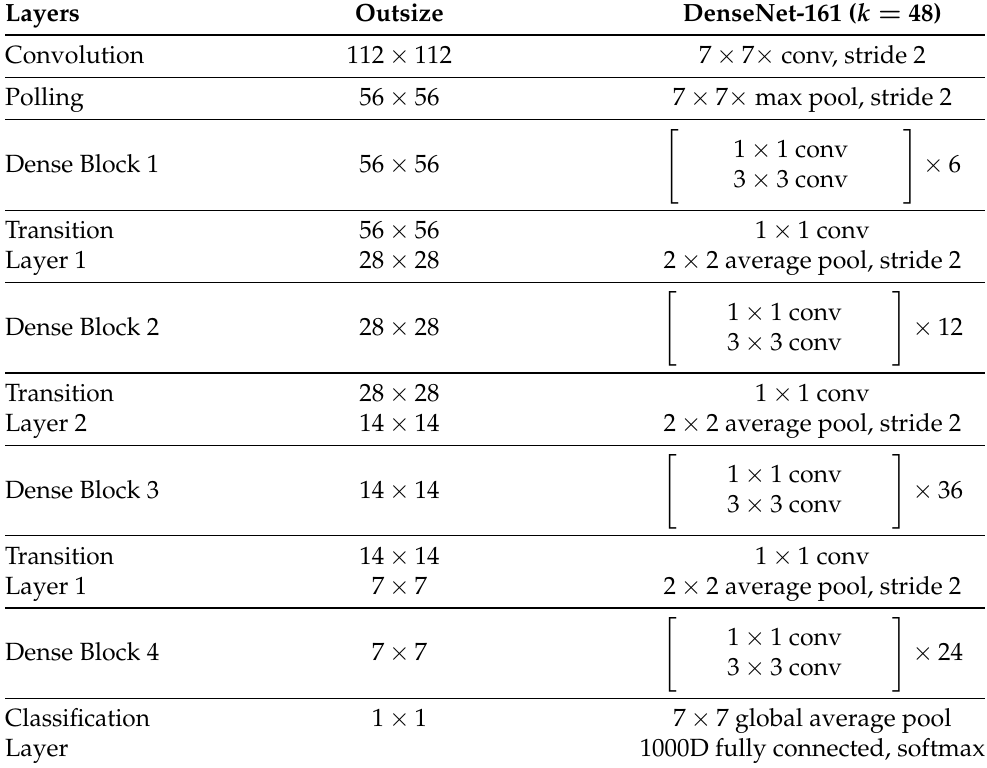
Table 6. DenseNet-161 architecture, the growth rate is k = 48 . Note that each “conv” layer shown in the table corresponds with the sequence BN-ReLU-Conv